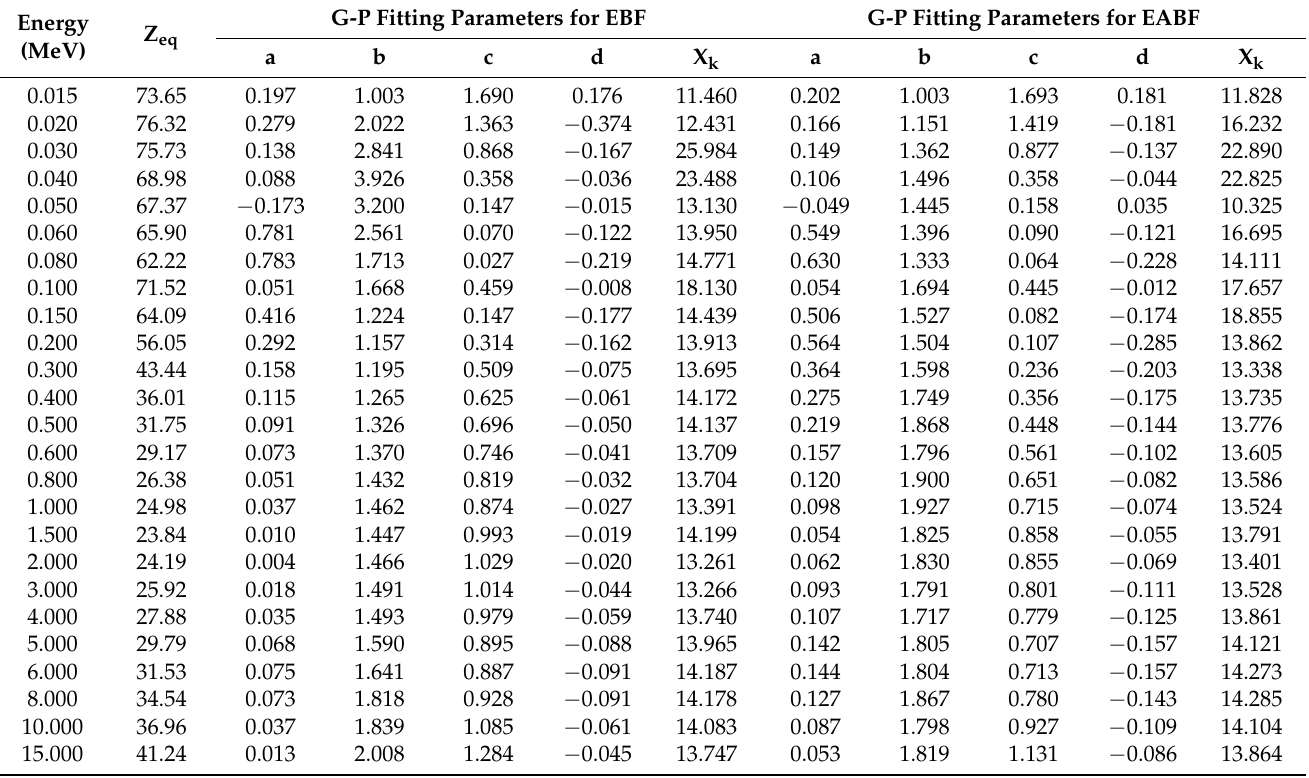
Table 6. (EBF and EABF) G–P fitting coefficients (b, c, a, Xk and d) of LPb50Eu2 glass